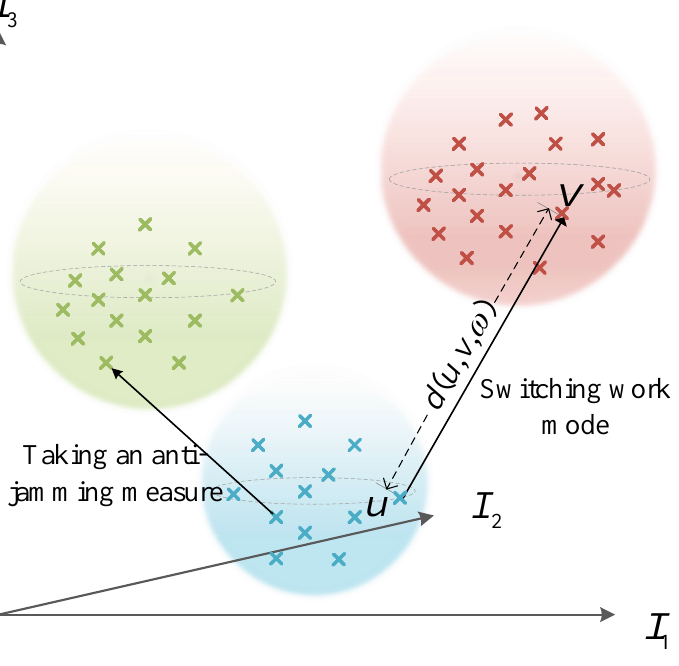
Figure 4. Vector space V 3 composed of three evaluation indicators. u , v are two evaluation indicator vectors, and d ( u , v , ω ) is the Euclidean distance between u and v with weight vector ω